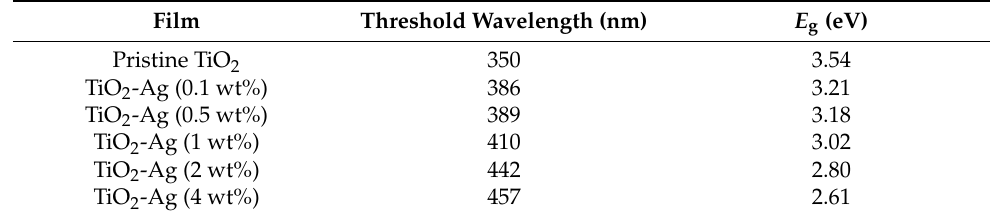
Table 1. Bandgap energies ( E g ) of the films.